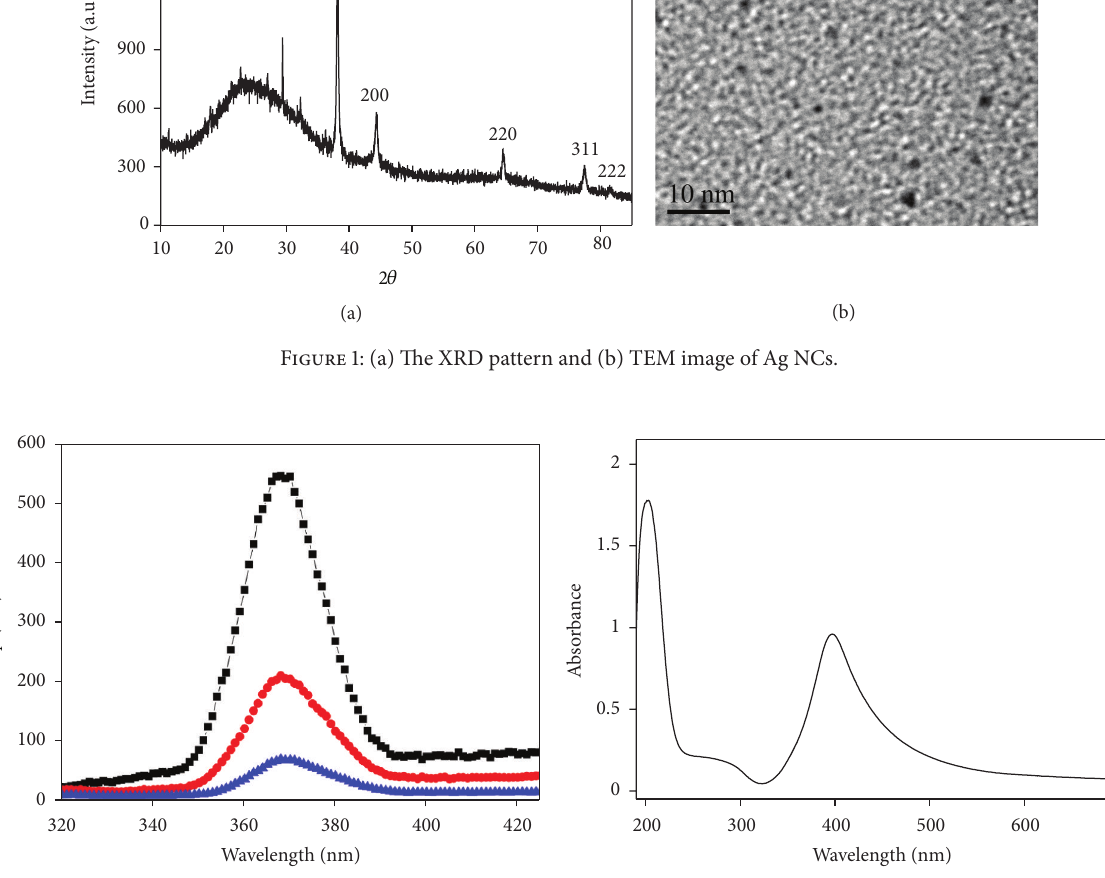
= 220 nm (black curve), 240nm (red curve), and 260 nm (blue curve), ex